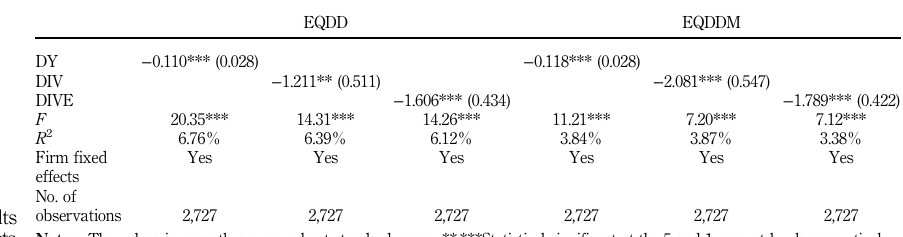
Table VII. The regression results with firm fixed